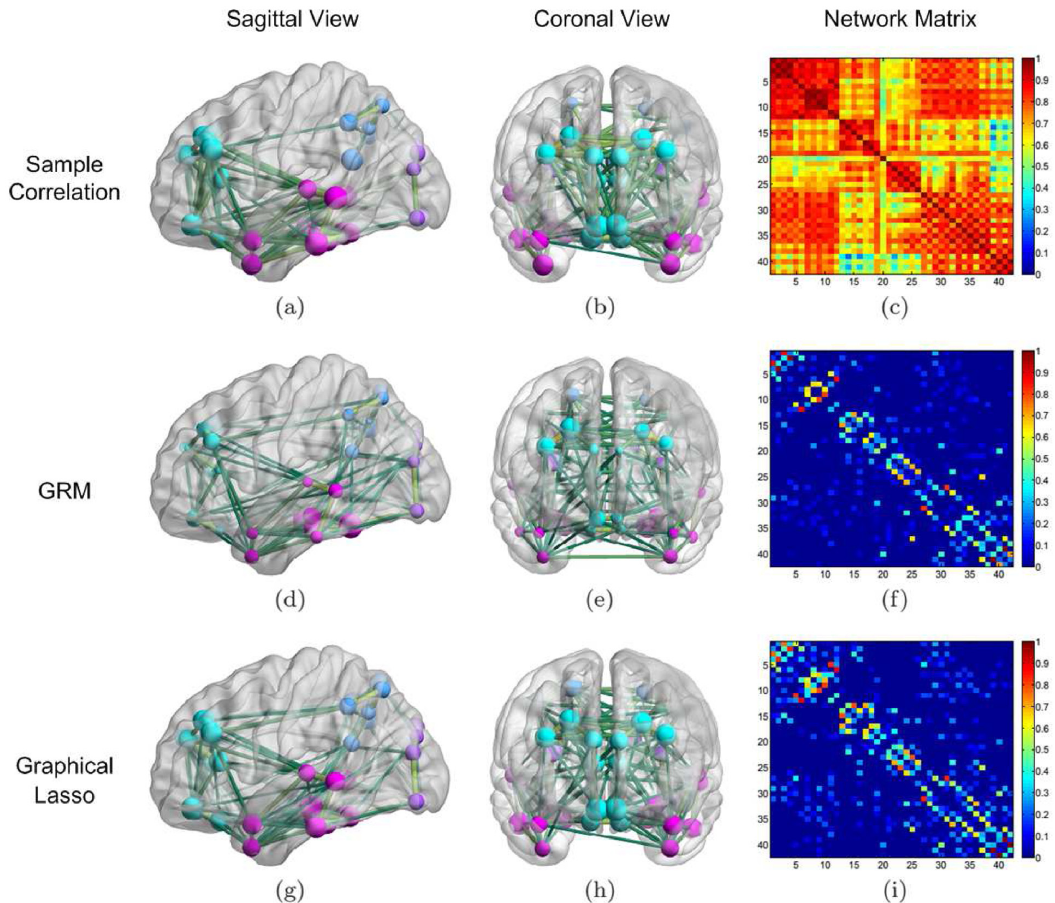
Fig 4. Network learning results of the AD group. Reconstruction results by the GRM (2nd row) from 30 AD subjects compared with those by sample correlation (1st row) and graphical Lasso (3rd row). We plotted the sagittal and coronal views of the thresholded networks in the first two columns, where 144 prominent links are shown for all cases. The colors and sizes of the nodes indicate the associated brain lobes (frontal lobe is cyan; temporal lobe is pink; parietal lobe is blue; occipital lobe is purple) and node degrees, respectively; the thicknesses of the edges encode the connection strengthes. Those figures were generated by BrainNet Viewer (http://www.nitrc.org/projects/bnv/). We used s = 2, β = − 0.003 and ρ = 0.002 to simulate (f) and (i), respectively. To ease visualization, we removed the diagonal entries when displaying the graph Laplacian and partial correlation